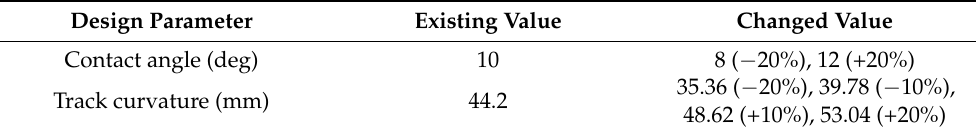
Figure 8. Methodology for GAF reduction and verification. Table 1. Design parameter variation.